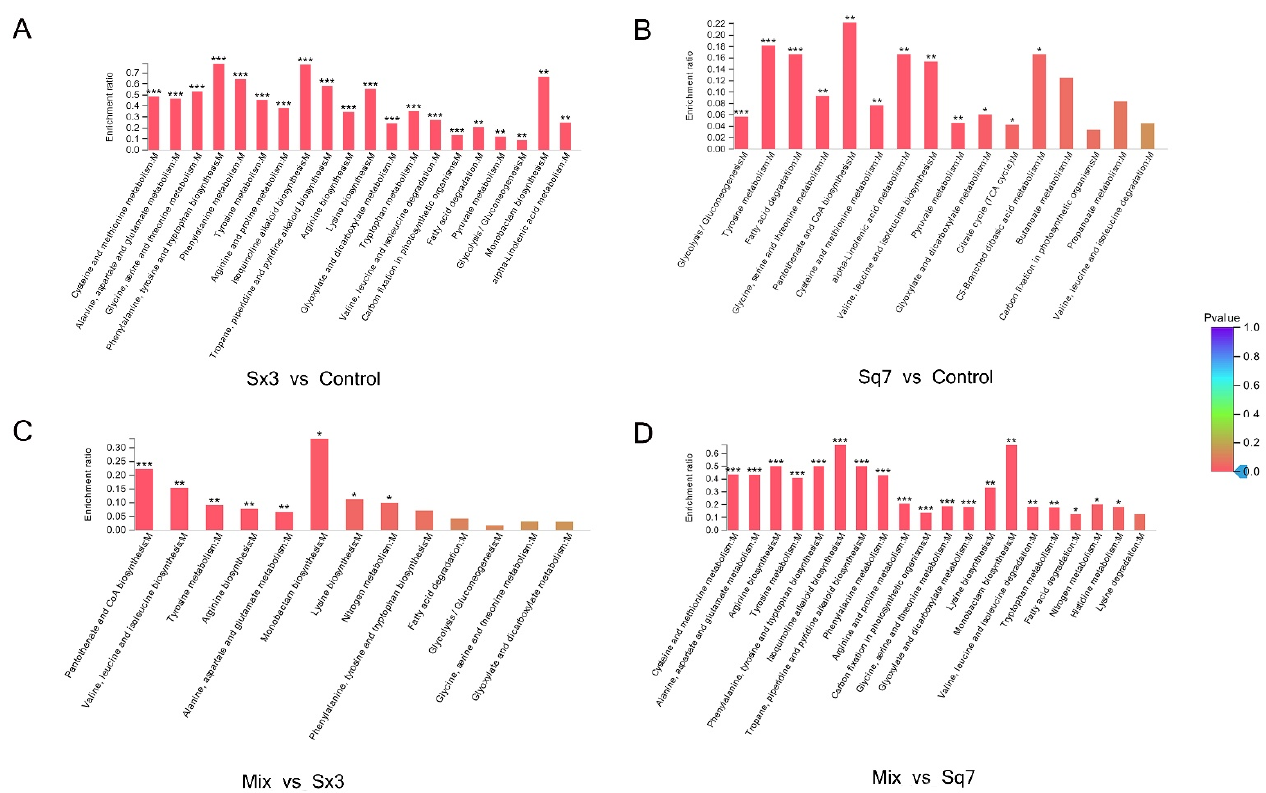
Figure 7. KEGG enrichment diagram of amino acid metabolism. The abscissa represents pathway name, and the ordinate represents enrichment rate (refers to the ratio of the protein number enriched in this pathway to the background number of the protein annotated into this pathway; the higher the ratio, the greater the degree of enrichment). The color gradient of the column represents the significance of enrichment. The deeper the default color is, the more significant the enrichment of the KEGG term is. “***” represents p < 0.001, “**” represents p < 0.01, and “*” represents p < 0.05.